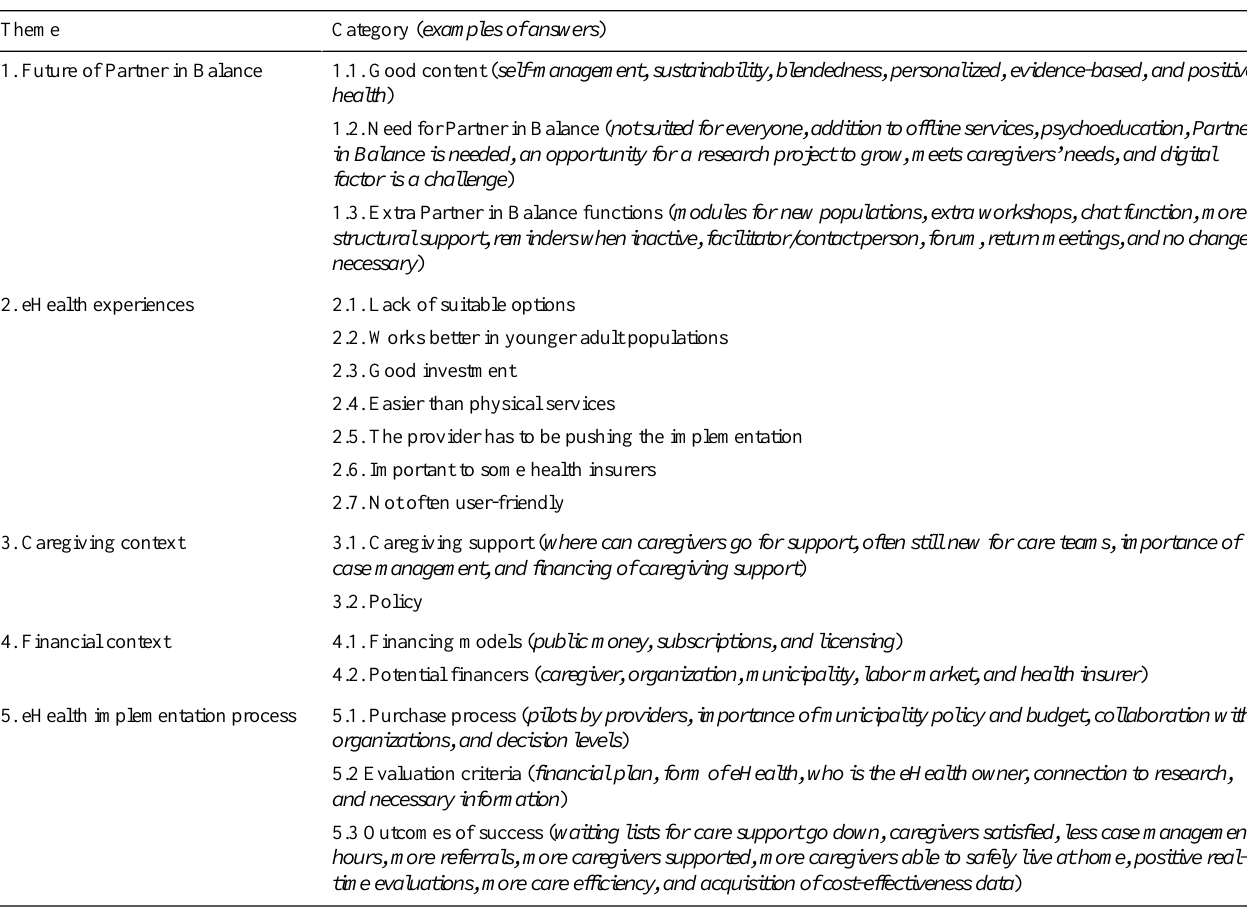
Table 2. Inductive interview themes.